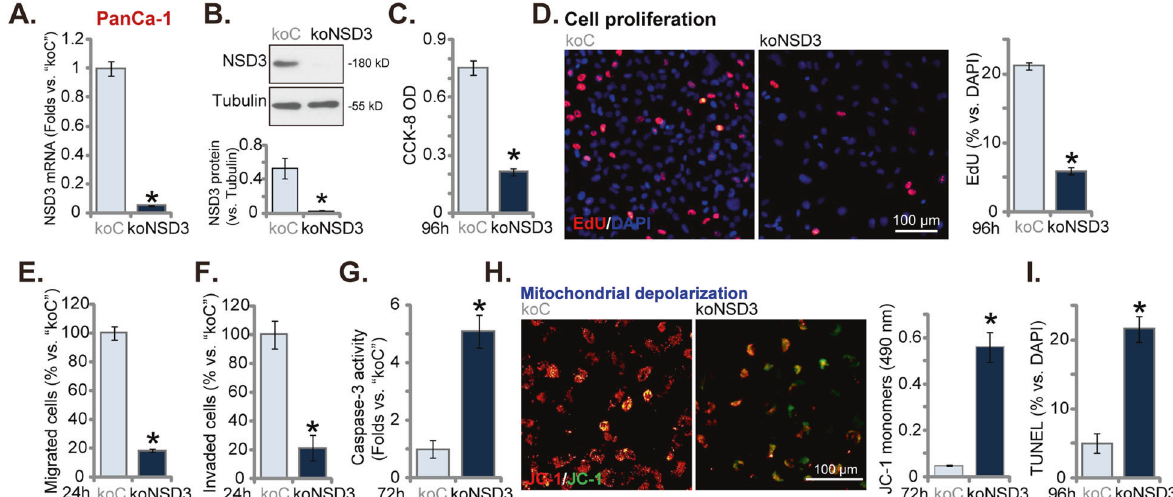
Fig. 4 NSD3 KO by CRISPR/Cas9 exerts tumor-suppressive functions in pancreatic cancer cells. Single stable PanCa-1 primary pancreatic cancer cells, bearing the lenti-CRISPR/Cas9 construct encoding NSD3 sgRNA ( “ koNSD3 ” ) or the lenti-CRISPR/Cas9 empty vector ( “ koC ” ), were established; expression of NSD3 mRNA and protein was examined by qRT-PCR ( A ) and western blotting ( B ) assays, respectively. Cells were further cultured for applied time periods, cell viability (CCK-8 assays, C ), proliferation (nuclear EdU staining assays, D ), as well as cell migration ( “ Transwell ” assays, E ) and invasion ( “ Matrigel Transwell ” assays, F ) were tested, with results quanti fi ed); caspase-3 activity ( G ), mitochondrial depolarization (JC-1 staining assays, H ) and cell apoptosis (TUNEL staining assays, I ) were tested as well. Data were presented as mean ± standard deviation (SD, n = 5). * P < 0.05 vs. “ koC ” cells. Experiments in this fi gure were repeated fi ve times with similar results obtained. Scale bar = 100 μ m ( D , H